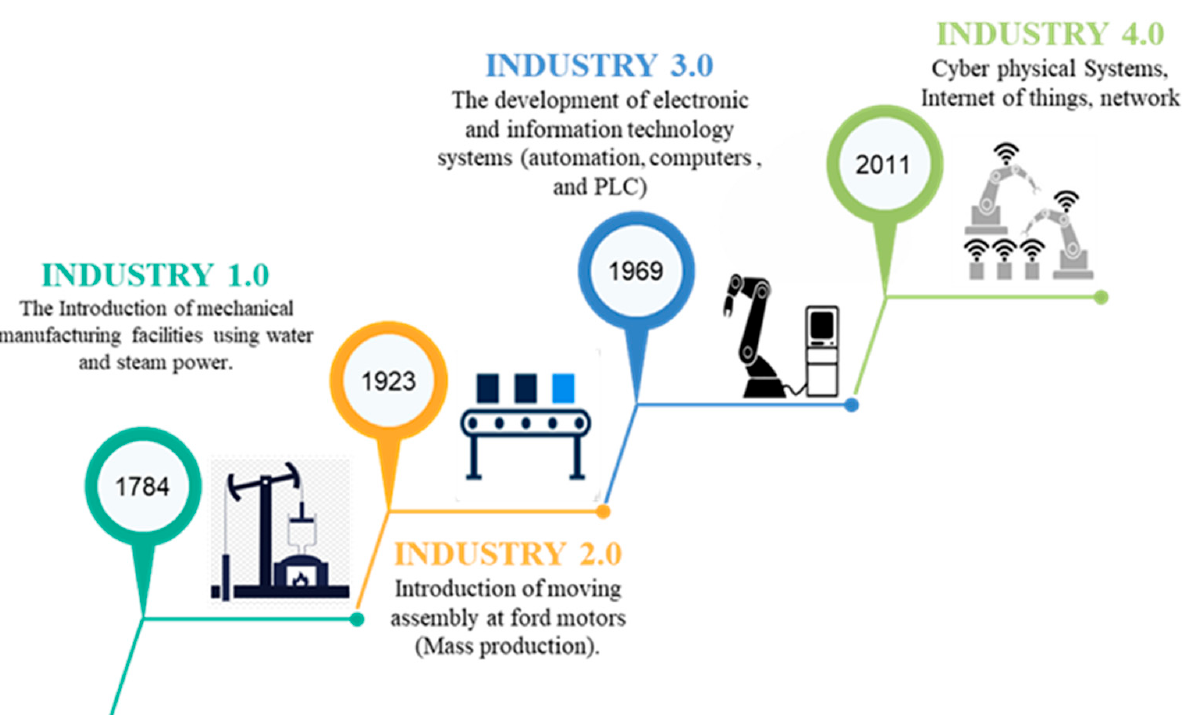
Figure 1. Historical development of the industry.